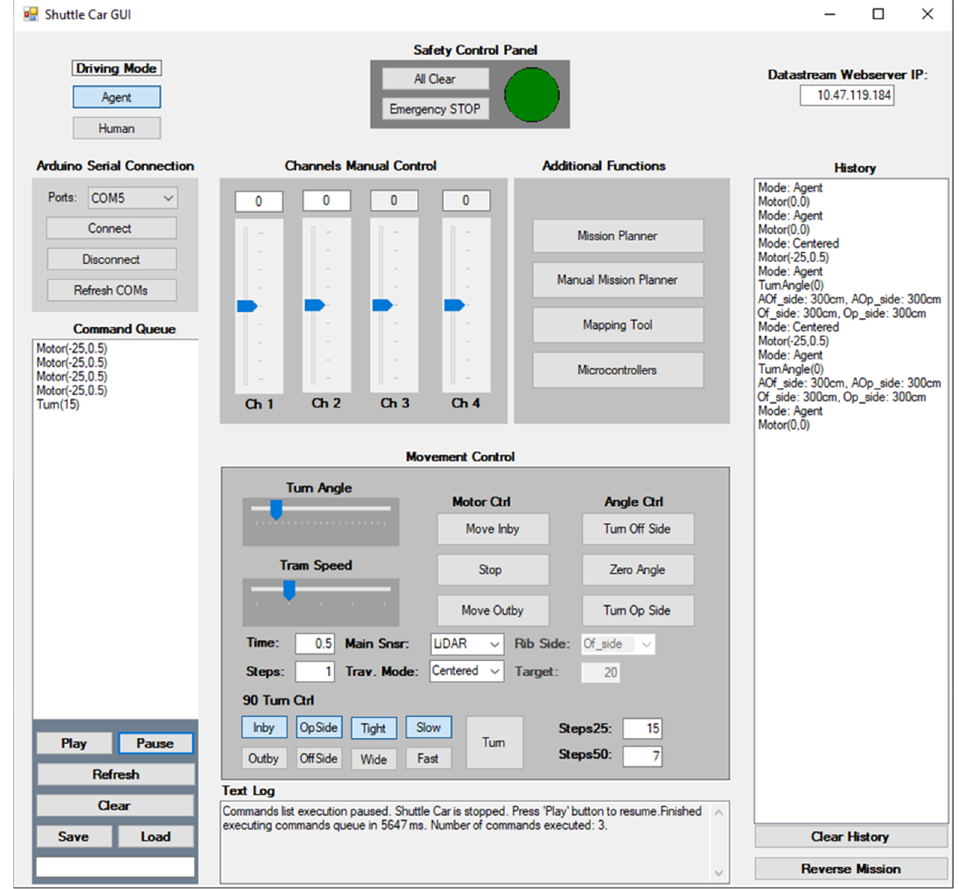
Figure 8. Main window of the shuttle car interface.